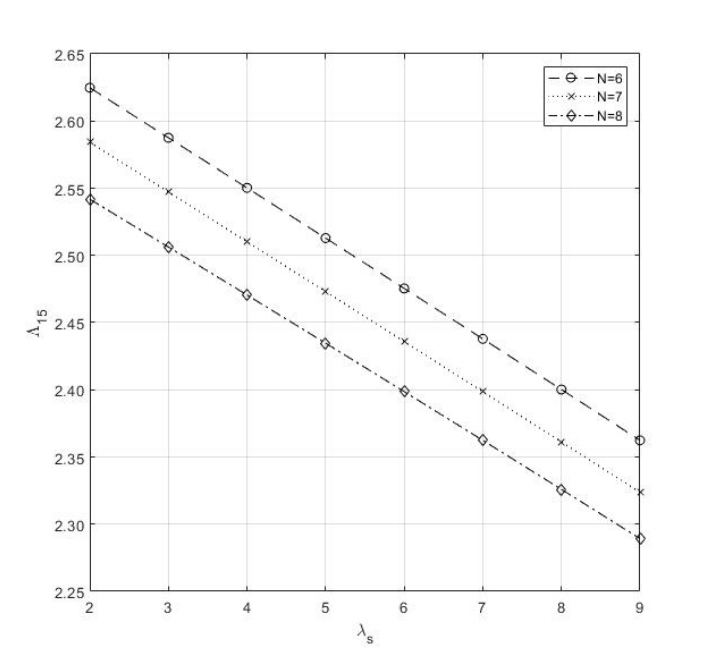
Figure 11. Mean number of Type-II Idle server of N vs. λ s